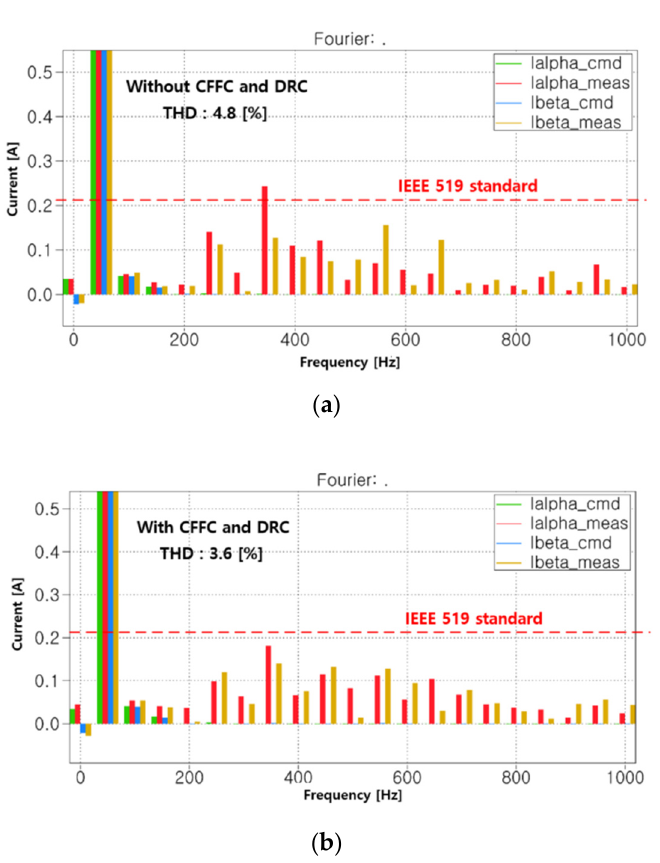
Figure 13. Under normal grid conditions, the frequency spectrums of the stationary reference frame grid currents ( a ) without CFFC and DRC and ( b ) with CFFC and DRC.